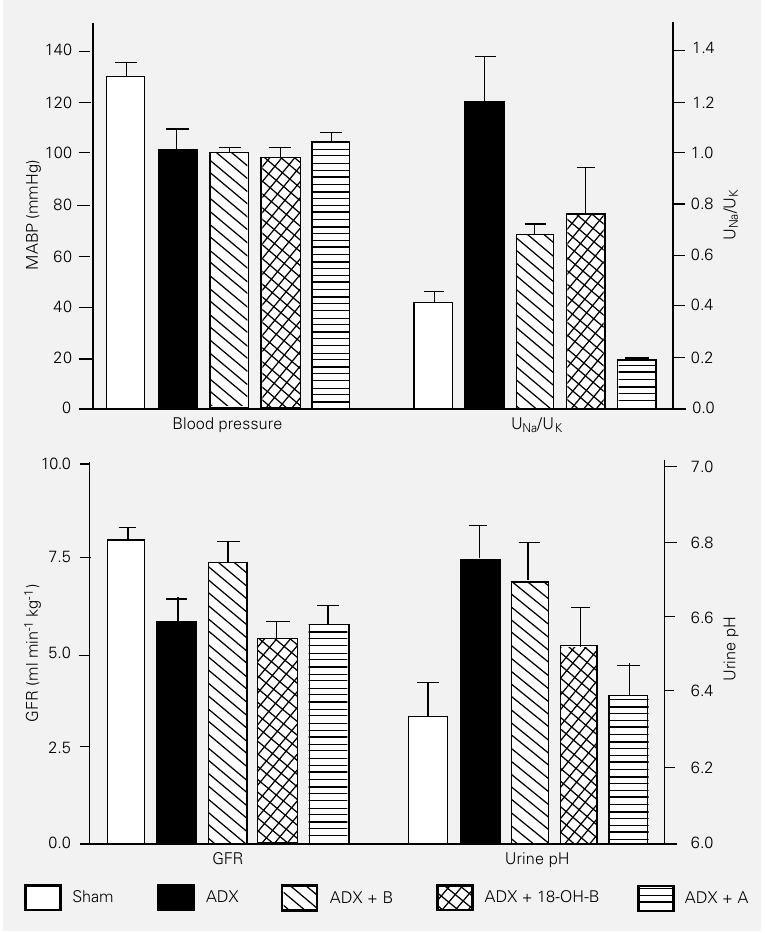
Figure 1 - General conditions of sham-operated and adrenalectomized (ADX) rats, and the effect of corticosterone (B), aldosterone (A) and 18-hydroxycorticosterone (18-OH-B) on ADX rats. U Na /U K , Urine Na + /K + concentration ratio; GFR, glomerular filtration rate per kg rat; MABP, mean arterial blood pressure. Data are reported as means – SEM. Data from Ref. 21, with